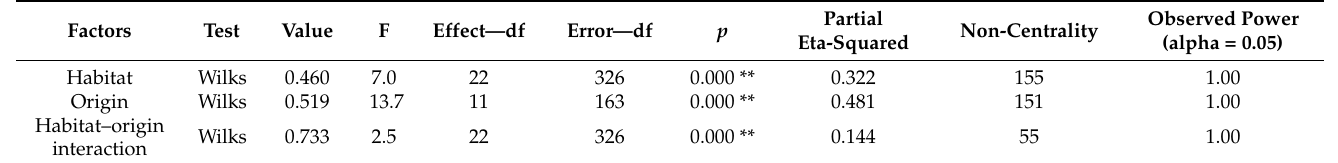
Figure 3. Effects of the genetic (origin) and environmental (habitat) factors and their interaction in the development of cranial bones in the cultivated and wild juvenile Atlantic salmon samples from the Shuya and Keret populations (ANOVA results for the 11 cranial bones indices). Table 5. Effects of the factors “habitat” and “origin” and their interaction on the development of cranial bones in Atlantic salmon (**, the difference was significant at p <